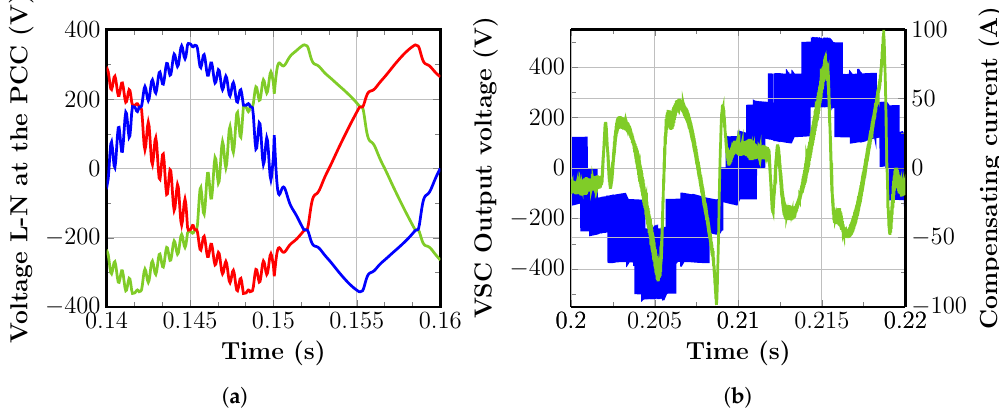
Figure 14. ( a ) V PCC behavior in presence of the 3L-NPC-based VSAPF. ( b ) 3L-NPC-based VSAPF